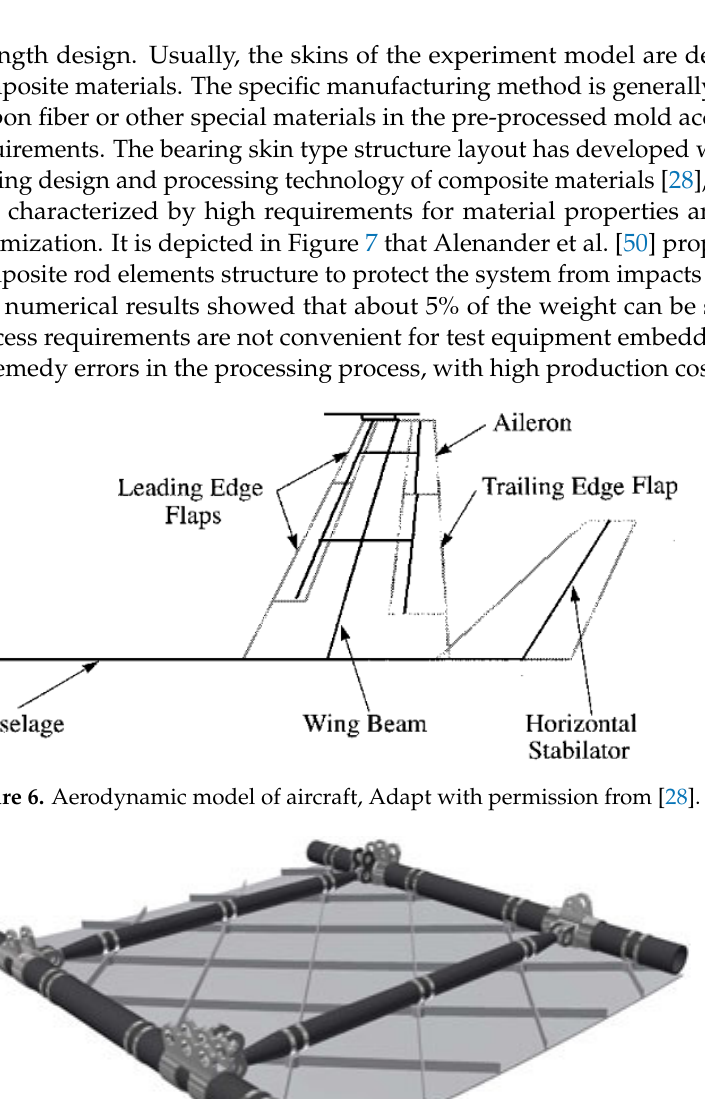
Figure 5. Single beam of wind tunnel model, Adapt with permission from [48].